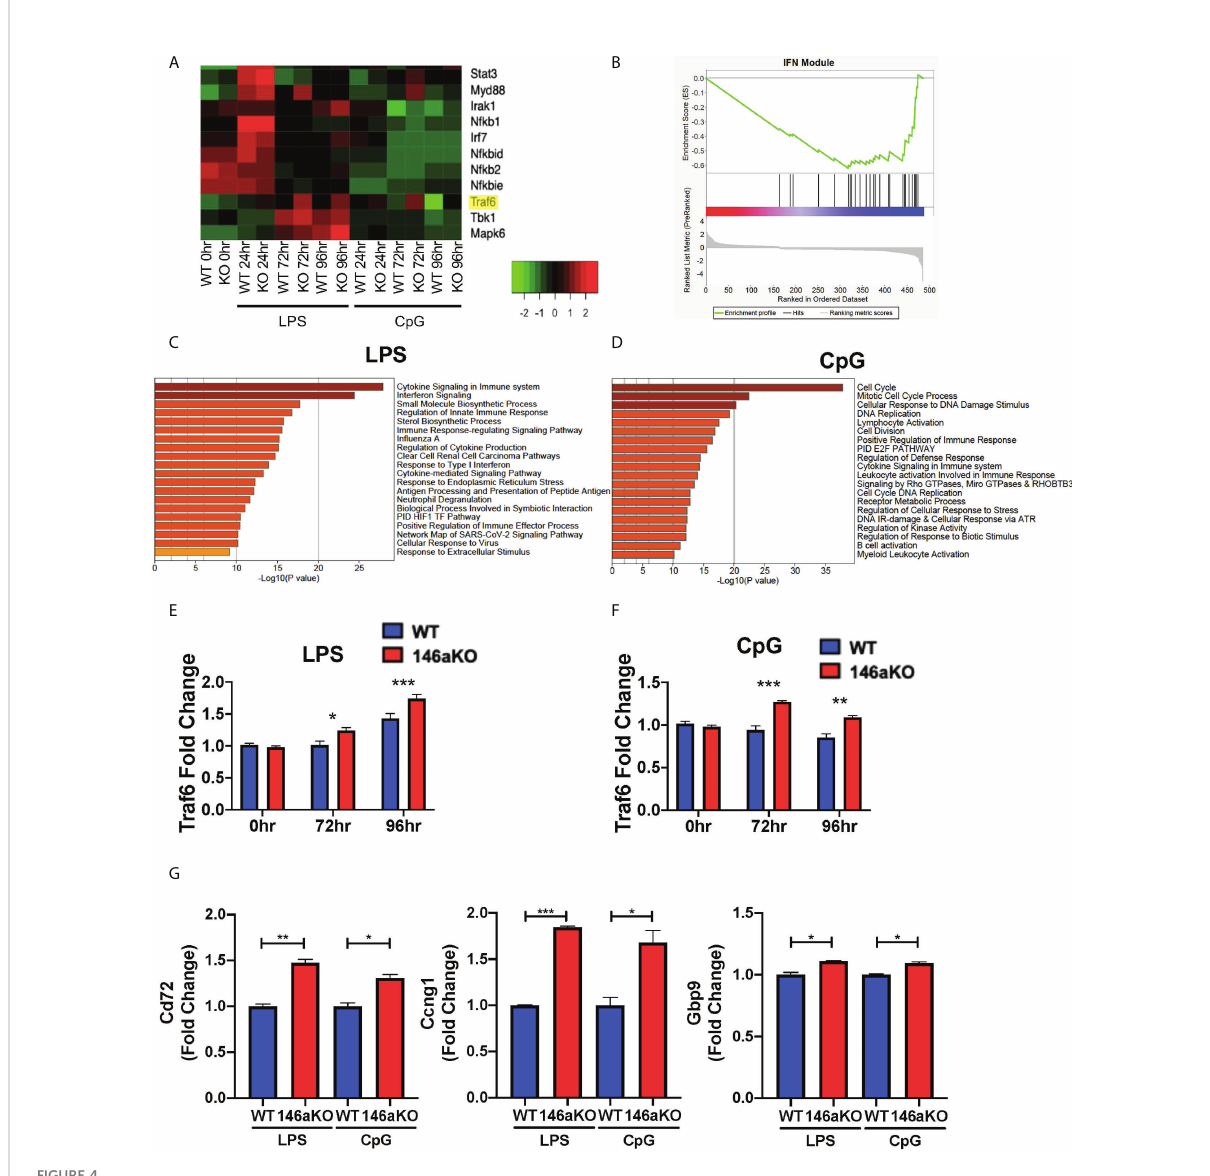
FIGURE 4 miR-146aKO B-cells have upregulated interferon pathway genes expression and Traf6 is a target for miR-146a dependent activation. (A) Snapshot of heatmap from the RNA-Seq data showing differentially expressed IFN targeted genes. miR-146a molecular target, Traf6 , is highlighted in yellow. (B) GSEA of genes differentially expressed between WT and miR-146aKO activated B-cells from LPS stimulation at 96 hours shows enrichment in Interferon Modules within SLE Disease. Normalized Enrichment Score: -1.94; FDR q value: 0.003. (C) Metascape enrichment analysis of differentially expressed genes between WT and miR-146aKO B-cells with LPS and (D) CpG stimulation show highest enrichment for genes within the Reactome Cytokine Signaling in Immune System and Interferon Signaling Pathways. (E) RT-qPCR validation for Traf6 expression with LPS and (F) CpG stimulation. One-way ANOVA with Tukey ’ s multiple-comparisons test; * P < 0.05, ** P < 0.01, *** P < 0.001. (G) RT-qPCR of downstream Traf6 genes in LPS and CpG-stimulated B-cells. t test; * P < 0.05, ** P < 0.01, *** P < 0.001. Data represent mean ± SEM. Graphs combine three independent experiments (n = 3-4